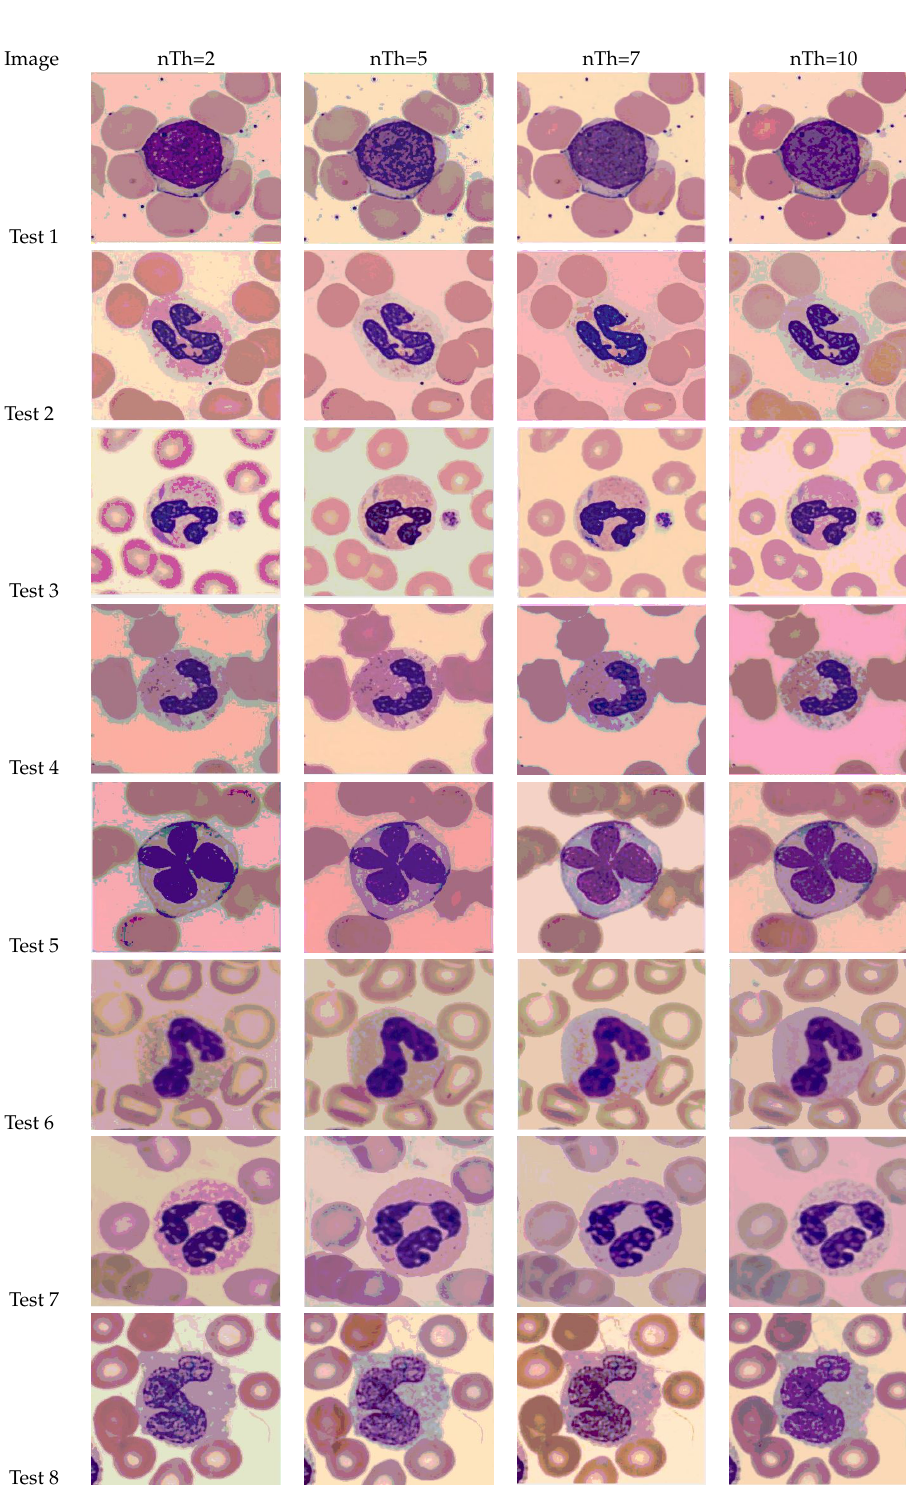
Figure A2. Outcomes after executing mSAR on the Otsu method over the set of test